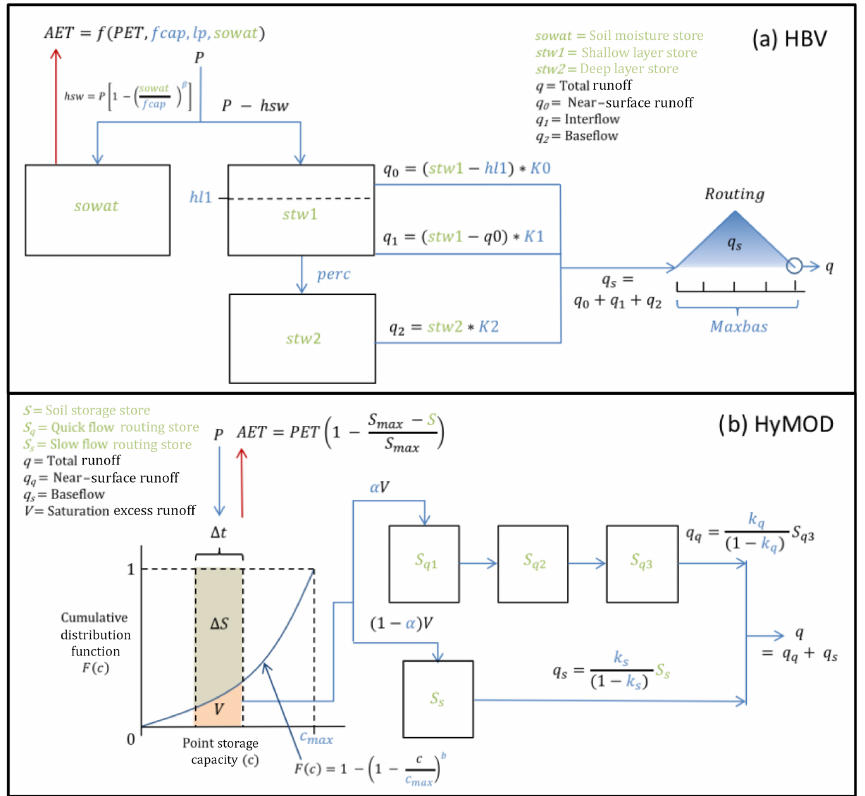
Figure 3. Schematic of the models used in this study: (a) HBV and (b) HyMOD. Parameters are shown in blue and states are shown in green.